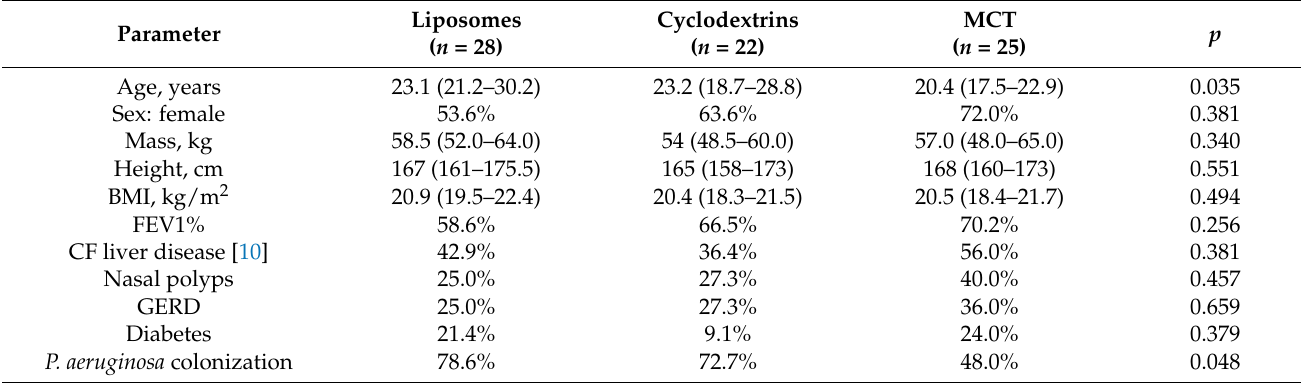
Table 2. Group characteristics at baseline. Medians (1st–3rd quartiles) are shown along with the p -value for the Kruskal– Wallis test or the Pearson’s χ 2 test.